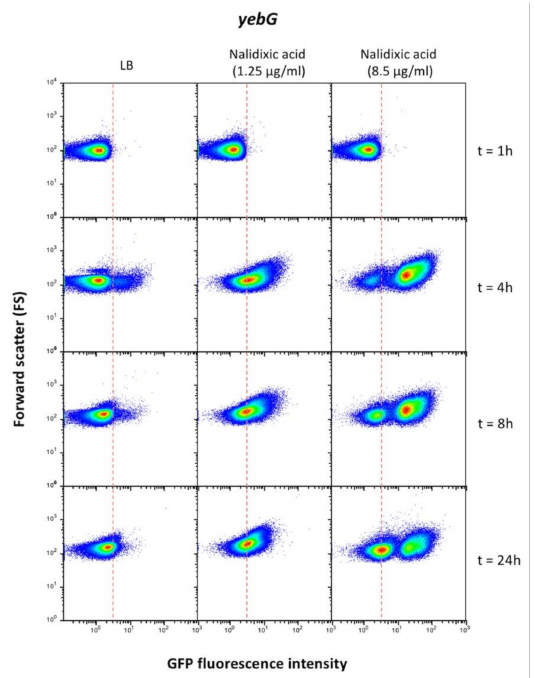
Figure 8. Single cell analysis of yebG expression in the presence of low and high concentrations of nalidixic acid. The time since nalidixic acid was added to the culture is indicated. The dashed line shows the boundary between OFF and ON states, established as the expression level of a nonfluorescent sample (Supplementary Figure